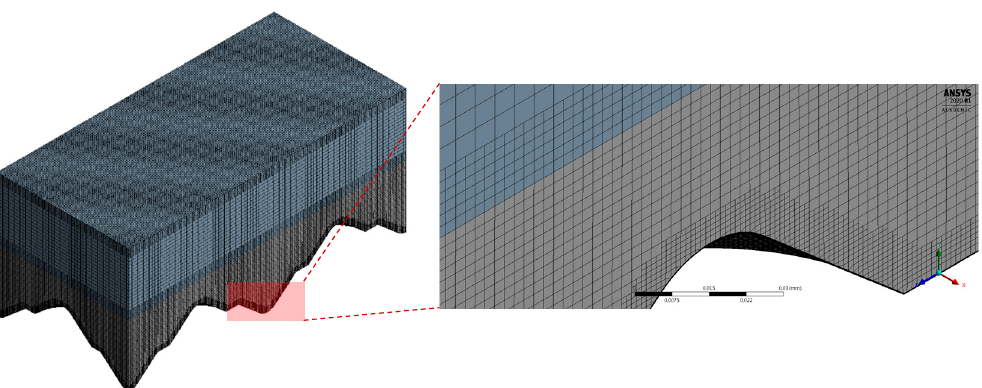
Figure 3. The mesh topology for the mid-level roughness.